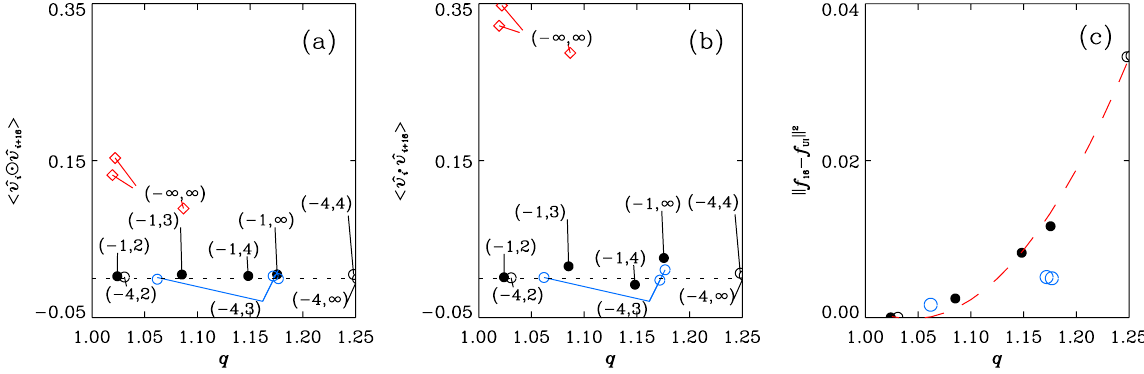
11 Figure 5. ( a ) The two-dimensional (2D) plot of the mean ∫ = + (Fig. 4) and q for  ˆ ˆ v v f x xdx ( ) i i 16 16 − systems with their parameters ( s A , s ) marked in the plot, the inner product is evaluated in terms of backbone coordinates, defined in Fig. 1(b); ( b ) the 2D plot of the mean ⋅ + ˆ ˆ v v evaluated in terms of simulation-box i i 16 2 defined by Eq. (10) as functions of q , (Fig. 1(c)) coordinates and q ; ( c ) the normed square deviation − f f 16 UI for the six systems (filled black circle) with s A = − 1 and s = 2, 3, 4 and ∞ , respectively, obtained with the data of f l , l = 16 plotted Fig. 4. These systems do not have aggregation processes. We also include the results for s A = − 4, and s = 2, 4 and ∞ , respectively, each of which has one data (in open black circle) in each of ( a – c ). There are three data points for ( s A , s ) = ( − 4, 3) (in open blue circle) in each figure, which have different values in q (at time t = 293.5, t = 353.5 and t = 822.5, respectively, in Fig. 6(b)). These four systems with s A = − 4 undergo aggregation processes. The data for those eight systems follow the same trends in plot (c), with eye-guidance by the dashed lines, except for the three data points for the system with ( s A , s ) = ( − 4, 3). In ( a ), the values of +  ˆ ˆ v v i i 16 are all vanishingly small for all the eight systems mentioned above (denoted by filled or open circles in black or blue colors), as the results of the correlation-anti-correlation symmetry, that between +  ˆ ˆ f v v ( ) i i 16 16 and − +  ˆ . The data points in plot (b) are systematically larger in magnitudes than those of their 16 counterparts in plot (a), suggesting the unique status of the backbones in referring to the symmetry, except the not-so-obvious results for the two cases with the weakest stiffness in each category, ( s A , s ) = ( − 1, 2) and ( s A , s ) = ( − 4, 2) and the two cases with strong stiffness in the category of s A = − 4, that is, ( s A , s ) = ( − 4, 4) and ( s A , s ) = ( − 4, ∞ . The analysis on the values of skewness of the distributions f l ’s for the cases of strong stiffness ( s A , s ) = ( − 4, 4) and ( s A , s ) = ( − 4, ∞ ), nevertheless, do show the consistent trend that support the above-mentioned conjecture. The directions of motion in all these eight systems are, therefore, in backbone-constrained isotropy, including the system with ( s A , s ) = ( − 4, 3), even though the latter has varying q * over time (Fig. 6(b)). We also include, in plots ( a , b ), three data points (red diamonds) for a system with ( s A , s ) = ( −∞ , ∞ ) (i.e. with rigid bond and vanishing angle potentials) and in absence of background fluid 48 . In this case, q varies over time in the for this system are much larger than those for the other eight aggregation process. The values in +  ˆ ˆ v v i i 16 systems and are not vanishingly small. The direction of motion is not in backbone-constrained isotropy in this case. Note that, the two systems with the weakest stiffness considered in the plots, ( s = 2, those for ( s A , s ) = ( − 4, 2 close to zero. Each of the two systems = ( − 1, 2) have their normed square deviation − f f − 2) and ( s A , s ) 16 UI show equally well correlation-anti-correlation symmetry, with the inner product computed in either backbone coordinates (plot (a)) or simulation-box coordinates (plot (b)), because of the uniform isotropy in f 16 factor j G ( v ) = 4 π v 2 , and found Eq. (4) still effective for analyzing non-equilibrium situations, originated from thermodynamic instability. Our next task is then to extend the temperature-reduced approach to resolve the following issues. Firstly, while the parameters Γ and q provides convenient signatures to find, respectively, the external and internal thermal equilibrations for a collection of polymer chains, we are lacking of knowledge on the underlying origins of the stability leading to the equilibration. Are they from the same origin or not? Secondly, the equilibration reached in six systems considered so far are derived from the same initial preparation. Over longer time scales for suffi- cient relaxations, allowing to erase the residual memory of initially excited collective modes 68 , in what form will the equipartition of energy prevail in these systems? Thirdly, the non-equilibrium situations considered so far are in forms of temperature varying caused by external source (heat from numerical noises). Whether and how the governance by backbone could sustain the stability under the intrinsic changes in a process of aggregation is subject to be examined. Fourthly, it is not clear whether there is a system in the class of model chains under our consideration does not have a backbone dominant ‘quasi-steady’ stability? We proceed to analyze the internal correlations along the chains, to underscore the effects of backbone con- nectivity. The quantities of which the pair correlation to be analyzed should not be directly dependent on temper- ature and should reflect the orientations of local coordinates of the curved frame along the backbones. Correlation-anti-Correlation Symmetry in directions of motions. We consider the pair correlation between the directions of motion for monomers along a chain, measured by the probability density f l of direction cosine